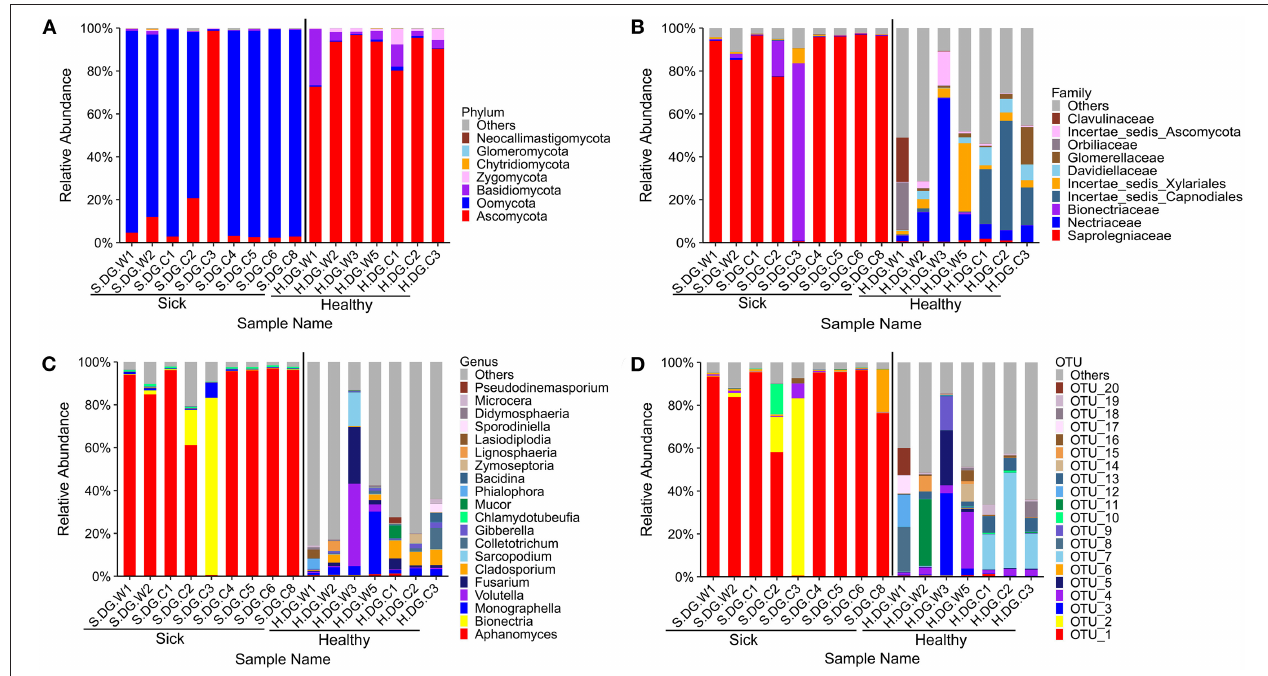
FIGURE 6 | Composition of cutaneous fungi of crocodile lizard at the phylum (A) , family (B) , genus (C) , and OTU (D) levels. The taxa with abundance of top 7, 10, 20, 20 were showed at the phylum, family, genus and OTU levels. The rest taxa with low abundance were included in “Others.” Group boundaries were separated by black vertical